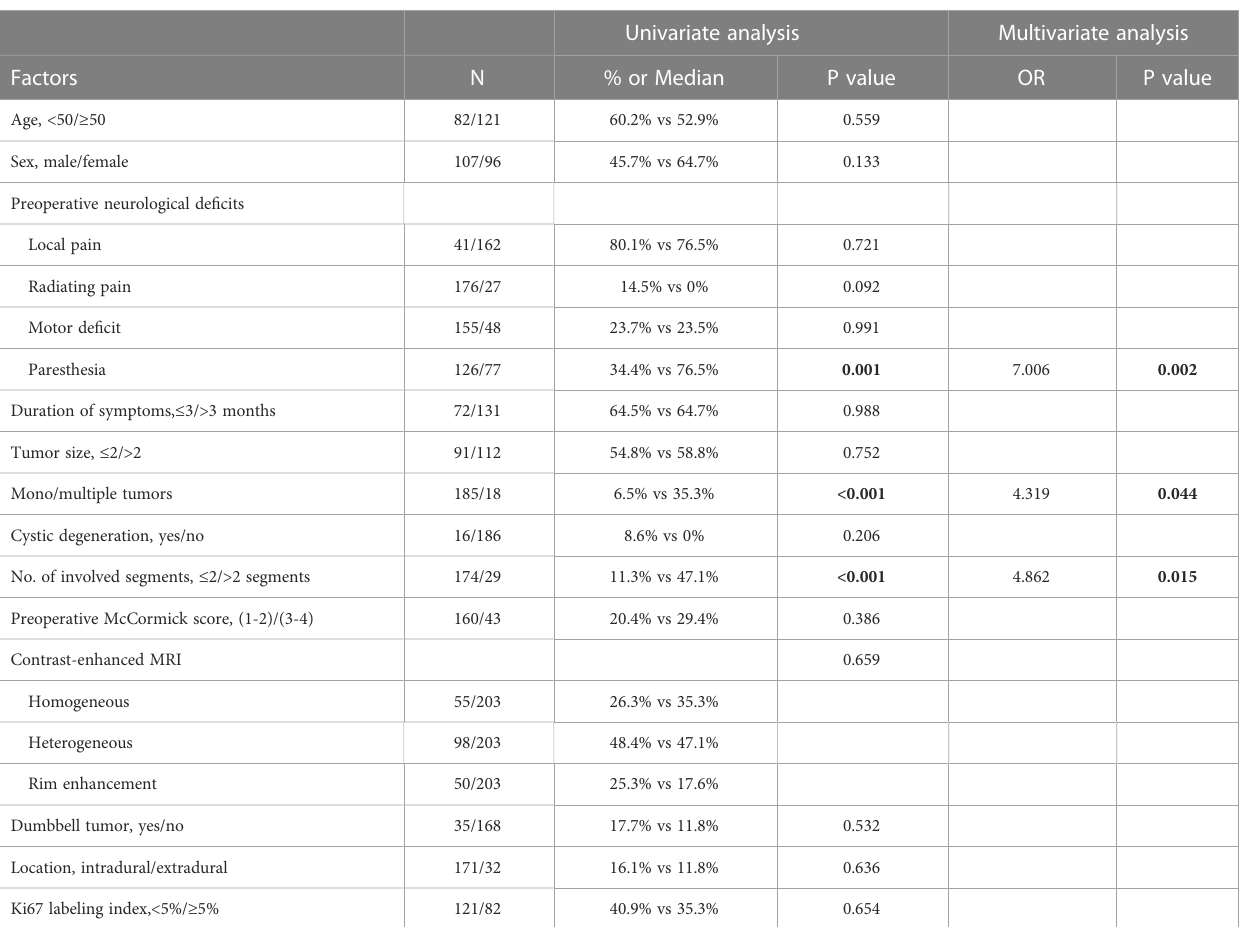
TABLE 2 Univariate and Multivariate logistic regression model for tumor-recurrence.